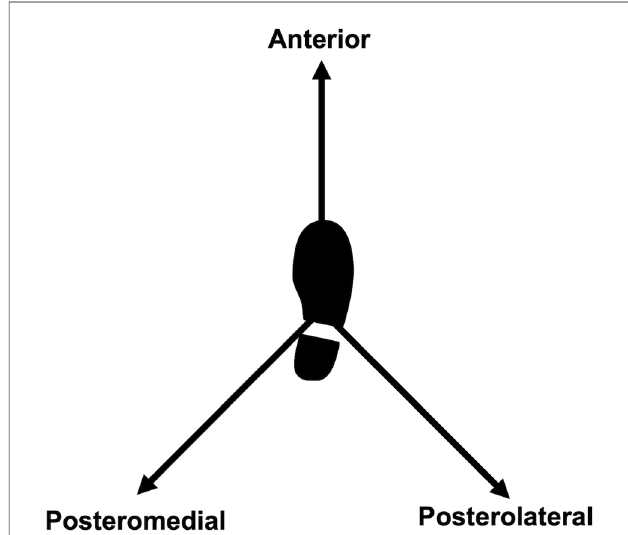
FIGURE 1 Representation of the modi fi ed star excursion balance test for the right weight bearing